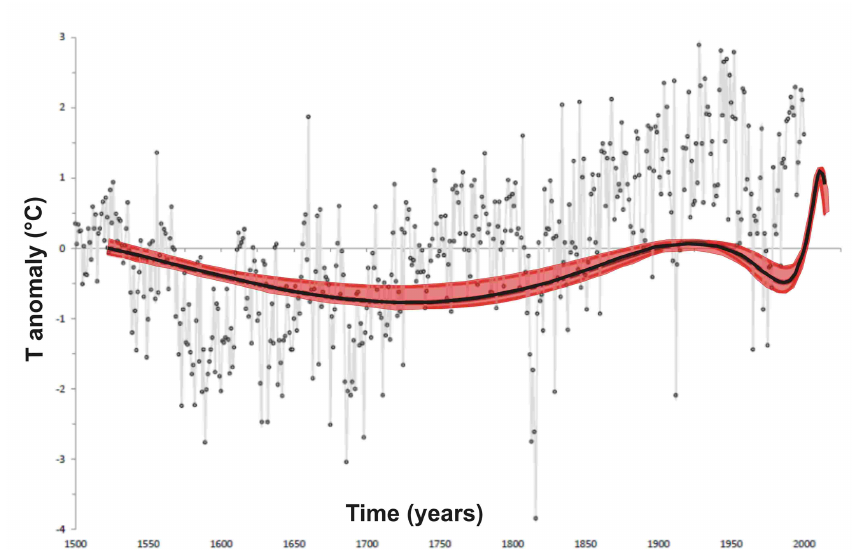
Figure 10. Comparison among the anomaly of the mean annual GST reconstructed by the SSB (black thick line), its uncertainty range (red shaded) and the MAAT anomaly reconstructed for the European Alps by Christiansen and Ljungqvist (2011) (grey line with dots; data available online at https://www.ncdc.noaa.gov/paleo/study/12355, last access: 19 June 2012), both in respect to the same reference period